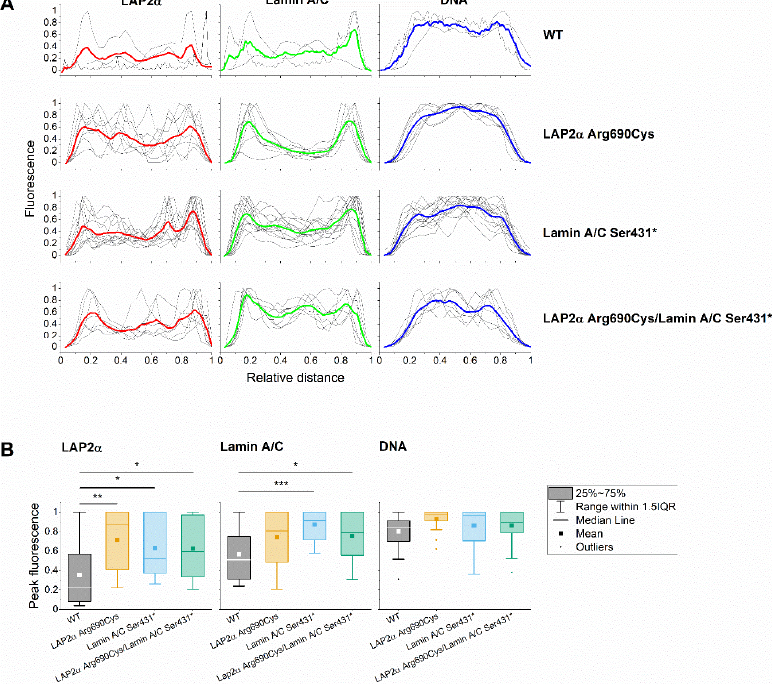
Figure 7. Mean peak fluorescence across leukocyte nuclei according to genotype. ( A ) Relative Lap2 α , Lamin AC, and DNA fluorescence signal intensity profiles along leukocyte nuclei cross- sections from individuals with different genotypes. Each gray line represents the profile of one nucleus, and the colored lines represent mean fluorescence intensities. ( B ) Box plots comparing Lap2 α , Lamin AC, and DNA mean peak fluorescent values in different genotypes. * p < 0.05; ** p < 0.01, *** p < 0.001. The analysis was performed using the images from Figure 5.